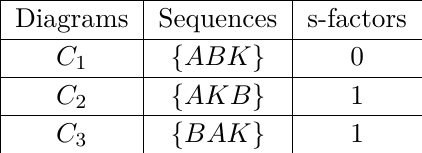
Table 10. Normal ordered diagrams of Cweb W (1 , 0 , 1)